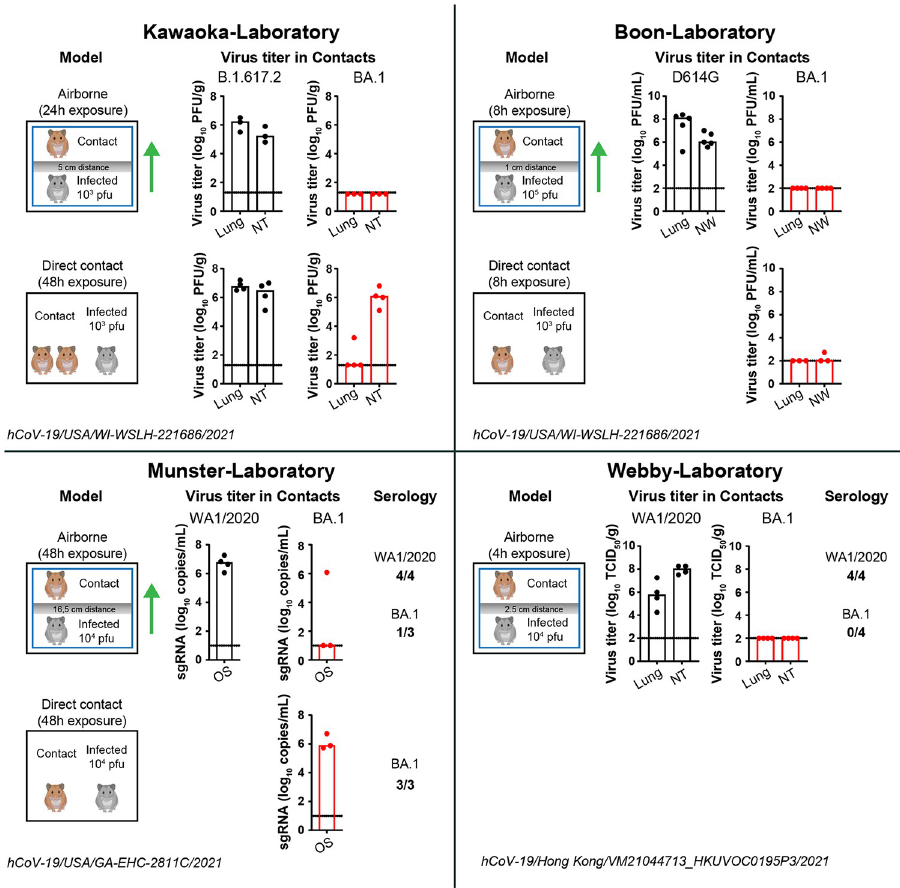
Fig 1. Inefficient airborne transmission of BA.1 variant of SARS-CoV-2 in Syrian hamsters. Experimental design and virus titers in the contact animals exposed to different isolates of the Omicron variant of SARS-CoV-2. Kawaoka- laboratory : Five- to six-week-old female Syrian hamsters were inoculated IN with 10 3 PFUs of the B.1.617.2 (Delta) or BA.1 (Omicron) variant and used as donor animals (grey hamster) in an airborne and direct contact transmission setup. Virus titer in the lungs and NT of the contact animals (brown hamster) was measured by plaque assay 3 dpe. Boon-laboratory : Five- to six-week-old male Syrian hamsters were inoculated IN with 10 5 PFU of a WA1/2020 virus engineered with a D614G mutation (D614G) or the BA.1 variant and used as donor animals in an airborne transmission setup. In a separate experiment, hamsters were inoculated IN with 10 3 PFU of the BA.1 variant and used as donor animals in a direct contact transmission setup. Virus titer in the lungs and NWs of the contact animals was measured by plaque assay 3 dpe. Munster-laboratory : Four- to six-week-old male and female Syrian hamsters were inoculated IN with 10 4 PFU of WA1/2020 or BA.1 variant and used as donor animals in an airborne transmission setup. Additional hamsters were inoculated IN with 10 4 PFU of the BA.1 variant and used as donor animals in a direct contact transmission setup. Virus titer in OSs taken from the contact animals was measured by RT-qPCR assay 3 dpe, and seroconversion was measured 14 dpe by spike antigen ELISA. Webby-laboratory : Eight- to ten-week-old male Syrian hamsters were inoculated IN with 10 4 PFU of the WA1/2020 or BA.1 variant and used as donor animals in an airborne transmission setup. Virus titer in the lungs and NT of the contact animals was measured by infectious virus assay 4 dpe, and seroconversion was measured 21 dpe by virus neutralization assay. Each symbol is an individual animal and the bars represent the median value. Dotted line indicates the limit of detection for each respective assay. Green arrow indicates directional airflow. This figure was created with a BioRender template (hamster image). dpe AU : AnabbreviationlisthasbeencompiledforthoseusedinFig 1 : Pleaseverifythatallentriesarecorrect : , days postexposure; IN, intranasally; NT, nasal turbinate; NW, nasal wash; OS, oral swab; PFU, plaque-forming unit; RT-qPCR, reverse transcription quantitave